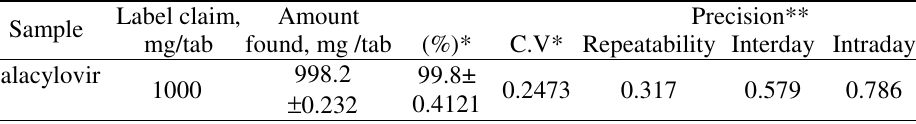
* Mean of six determinations. **%RSD of six